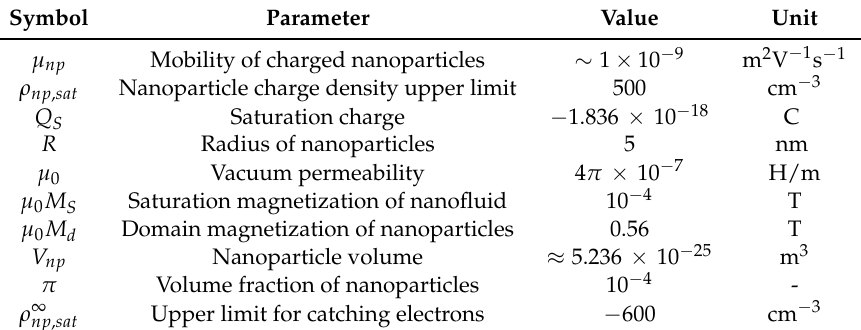
Table 3. Values of the new parameters used in the streamer simulation for nanofluids.